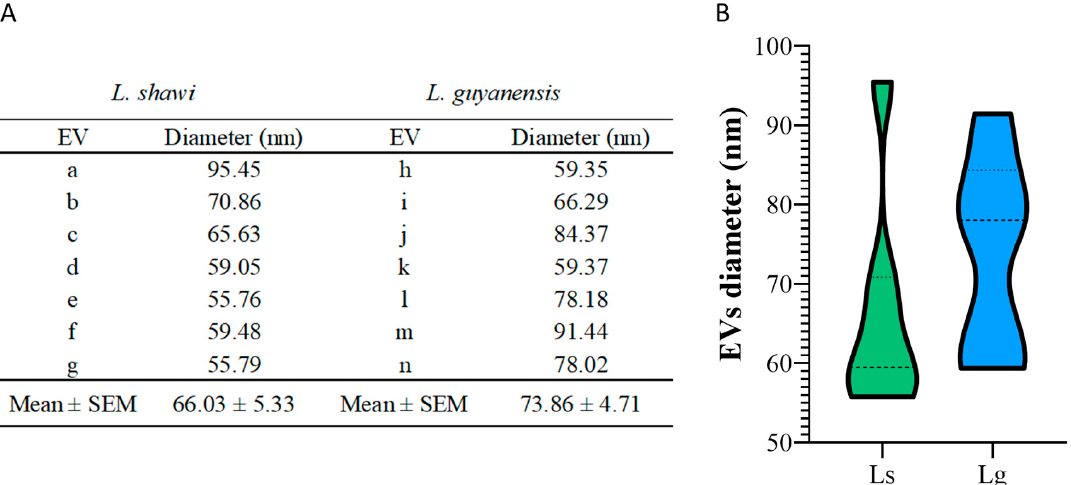
Figure 2. Diameter of EVs shed by L. shawi and L. guyanensis promastigotes. The diameter of EVs observed in Figure 1 were analyzed and are shown in table ( A ). a to g are measurement of EVs from L. shawi and h to n are values obtained for L. guyanensis EVs with Mean and standard error of the mean (SEM). EVs diameter (nm) distribution is shown by the violin plot ( B ).